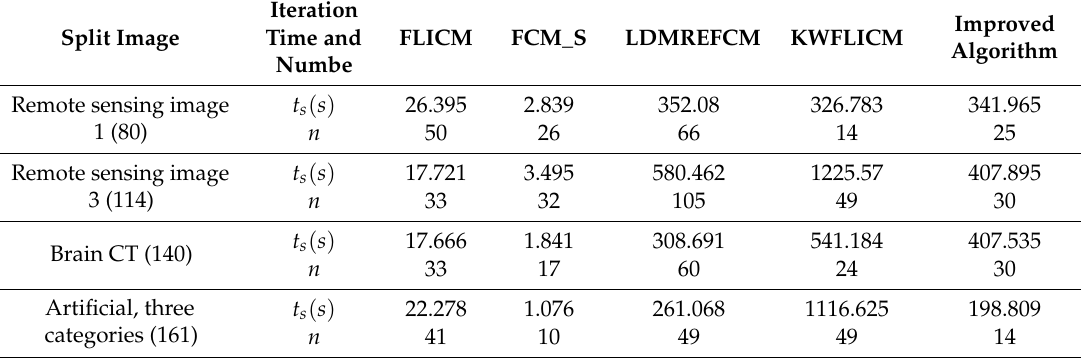
Table 9. Iteration time and number of iterations for each